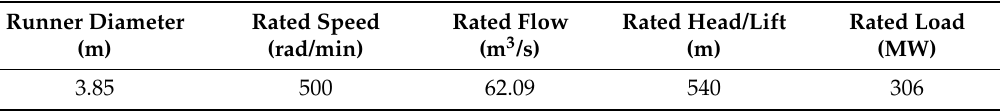
Table 3. Actual physical parameters of the pump storage plant and pumped storage hydro unit. Runner